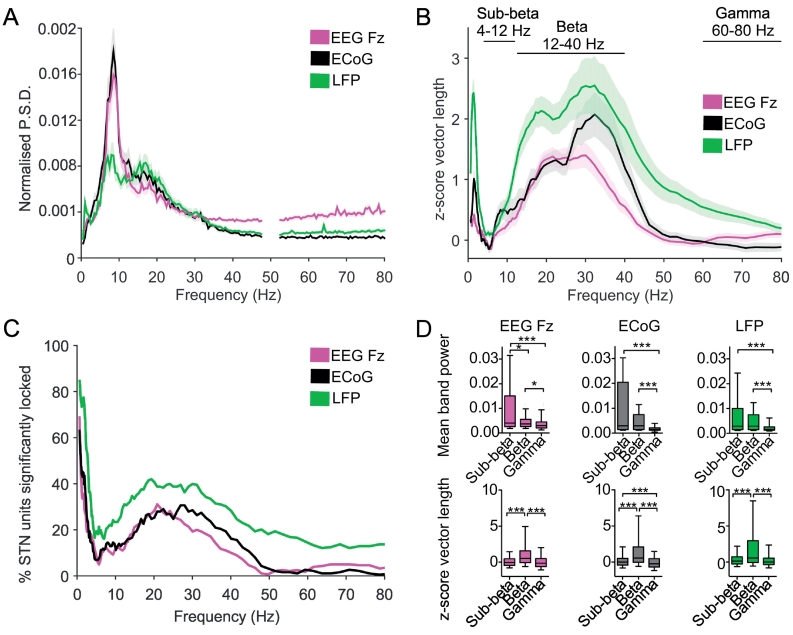
STN units were selectively phase-locked to beta oscillations despite the presence of higher power of oscillatory activity in the sub-beta-frequency range. A, Mean 1/f normalised relative power spectral estimates normalised by the power from 0.5–80 Hz for EEG Fz (n = 142), ECoG (n = 96) and LFP (n = 130). Shaded areas show +/− SEM. Please note that for spectral analysis LFP recordings were averaged per recording depth. B, Phase-locking strength for each of the STN units to EEG Fz (n = 280), ECoG (n = 186) and LFP (n = 248). N-numbers refer to unit-field pairs, in case of LFP recordings phase-locking strength has been averaged for multiple LFP signals per unit prior to group analysis. Note the selectively high phase-locking strength within the beta-frequency range. C, The histogram of the proportion of significant phase-locked units, determined by a significant Rayleigh test, shows a broad peak in the beta-frequency range. D, The mean relative power in sub-beta- (4–12 Hz), beta- (12–40 Hz) and gamma-(60–80 Hz) frequency range (top, same n-numbers as in A) and comparison of the phase-locking strength in the same frequency bands (bottom, same n-numbers as in B). Note the significantly higher phase-locking strength of STN units to beta oscillations despite the higher spectral power for sub-beta oscillations. Significance was tested using a Kruskal-Wallis ANOVA with post hoc Dunn's test. *** p < 0.001, * p < 0.05. Box plots show the quartile boundaries with whiskers showing the 5–95 percentiles.